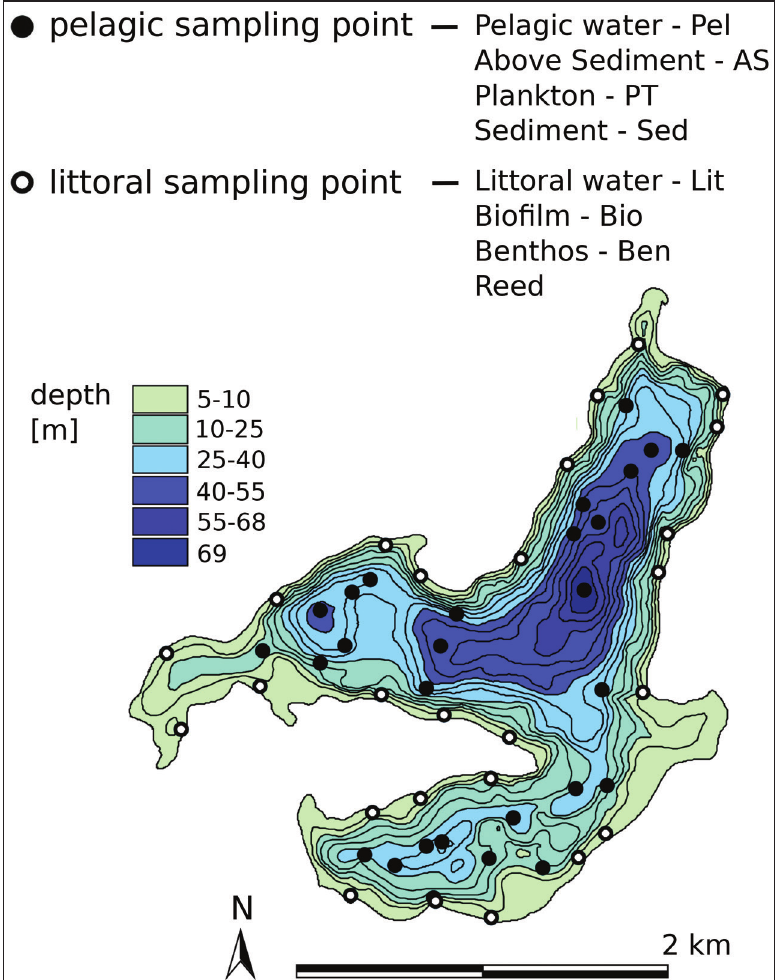
Figure 1. Sampling sites in Lake Stechlin. Integrated water samples, above-sediment water, plankton (> 55 µm), and sediment were taken from pelagic locations. Surface water samples, reed plants ( Phragmites australis ), biofilm samples (from stone, wood and macrophytes) and benthic samples (detritus, macrozoo- benthos) were taken from littoral